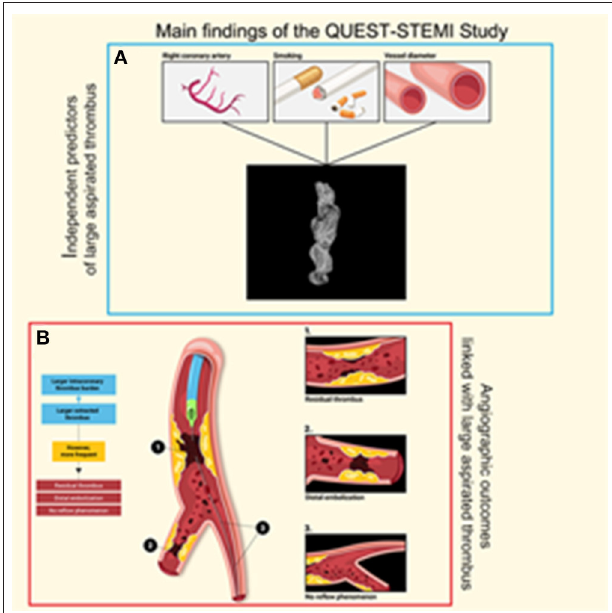
FIGURE 4 | Visual overview of the main findings of the QUEST STEMI study. (A) Independent predictors of large aspirated thrombus and (B) Angiographic outcomes linked with large aspirated